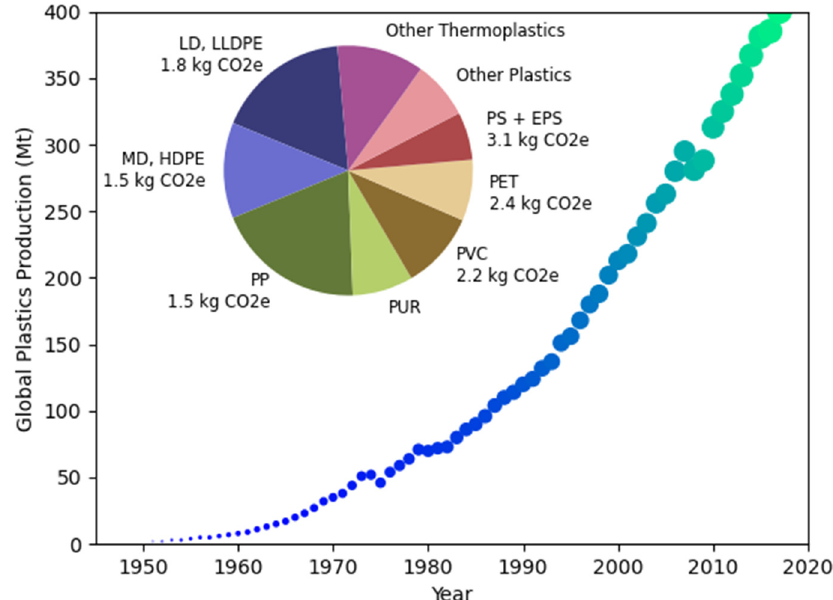
Figure 1. World plastic production throughout the years (1950–2019) [5,19–23] and the most pro- duced resins in 2019, with the respective global warming impacts (GWIs) [7]. Mt: megaton; PS: pol- ystyrene; EPS: expandable polystyrene; PP: polypropylene; MD, HDPE: medium-density/high-den- polystyrene; EPS: expandable polystyrene; PP: polypropylene; MD, HDPE: sity polyethylene; LLDPE: linear low-density polyethylene; LDPE: low-density polyethylene; PUR: polyurethane; PET: poly(ethylene terephthalate); PVC: poly(vinyl chloride); other plastics include